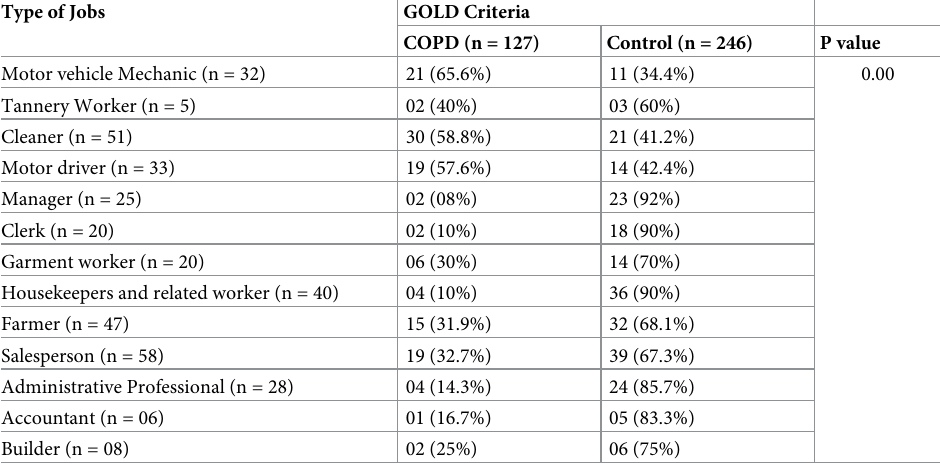
Table 2. Types of jobs reported by the participants.